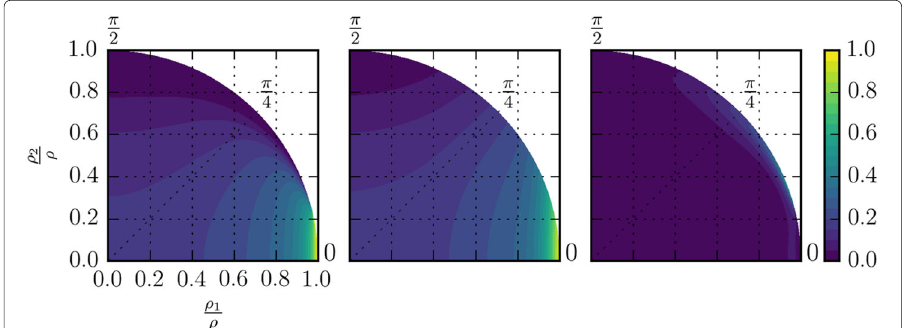
Fig. 15 Ratio of screw dislocation density ρ s /ρ as a function of GND vector and total dislocation density. Left: Evaluated from integrating the DODF of CDD ( 1 ) using (41); Middle: Analytical approximation of screw density ratio given by (89); Right: the absolute error of the